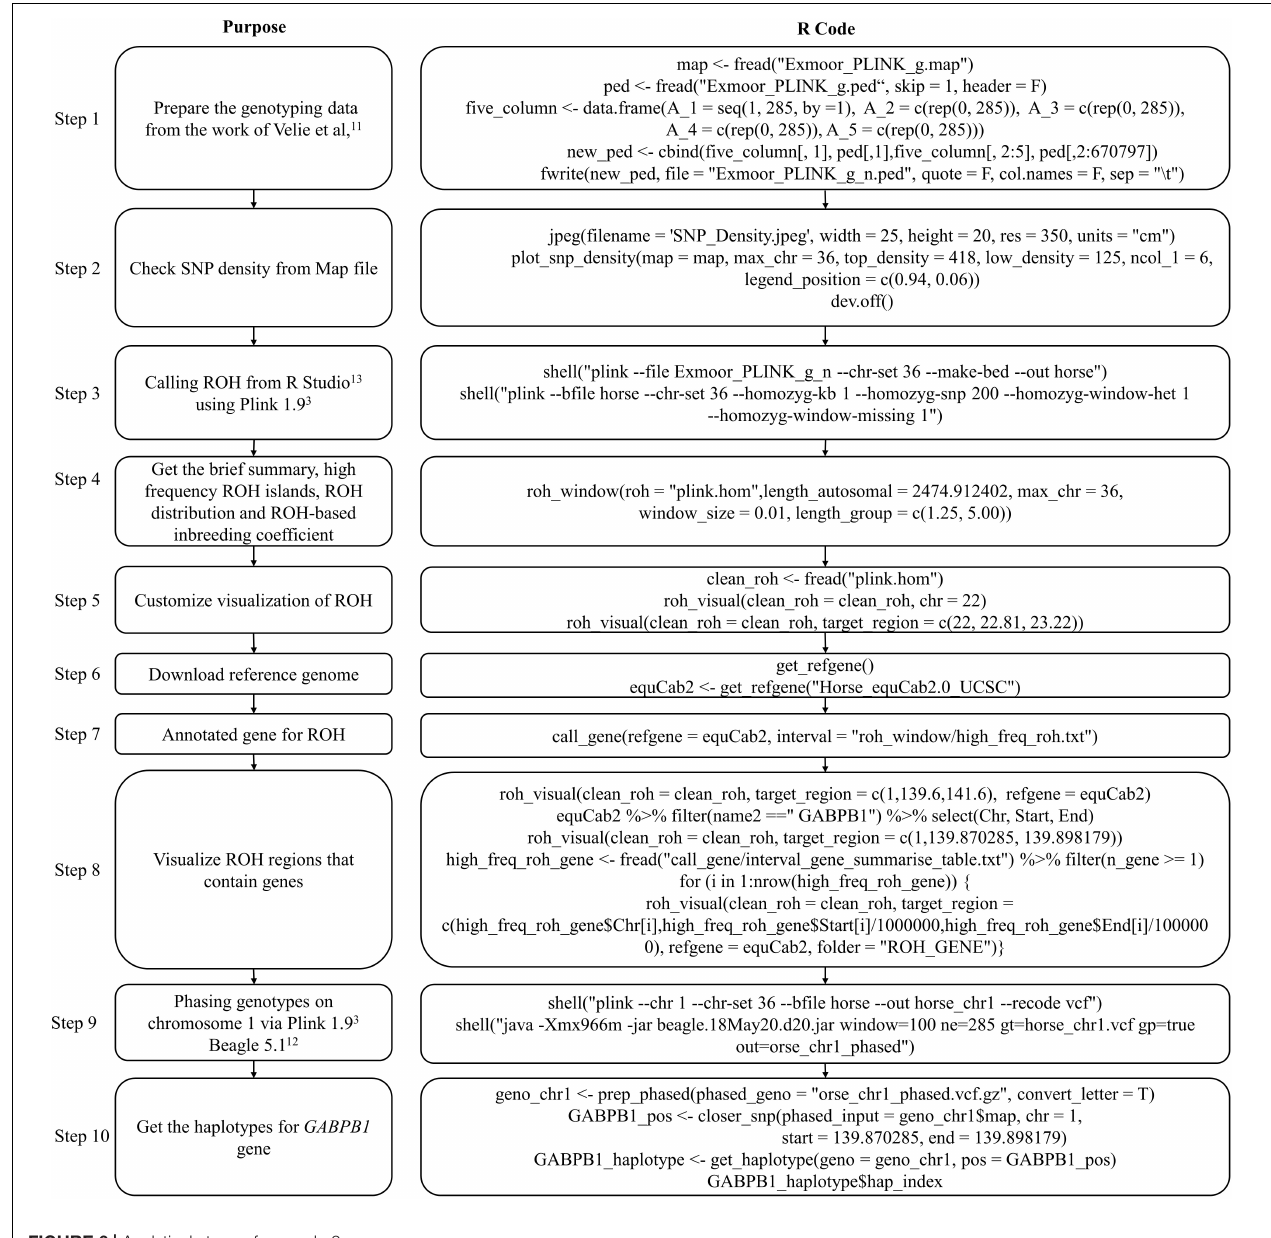
FIGURE 6 | Analytical steps of example